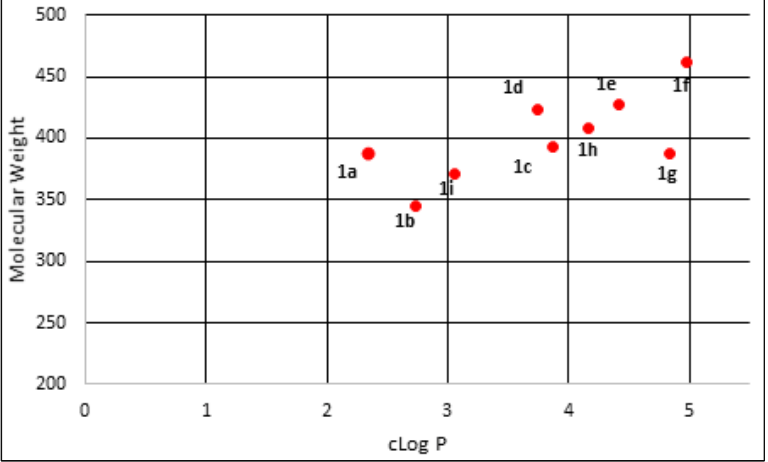
Figure 2. cLogP versus molecular weight distribution of synthesized 4-methoxychalcone